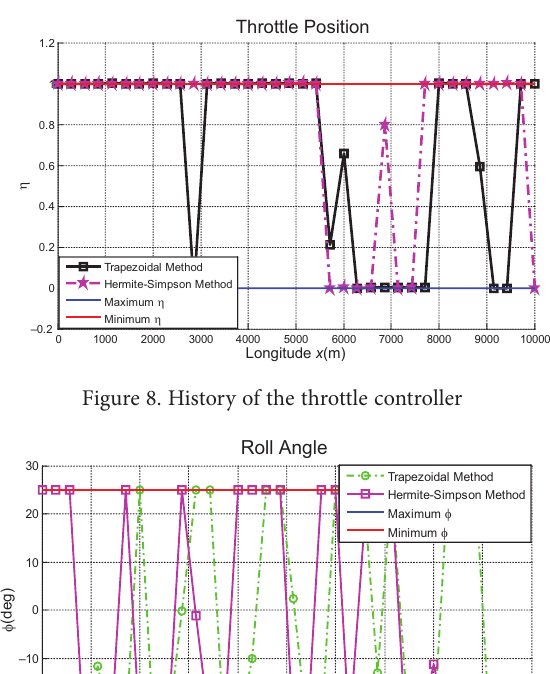
Figure 7. Velocity curve of the UAV